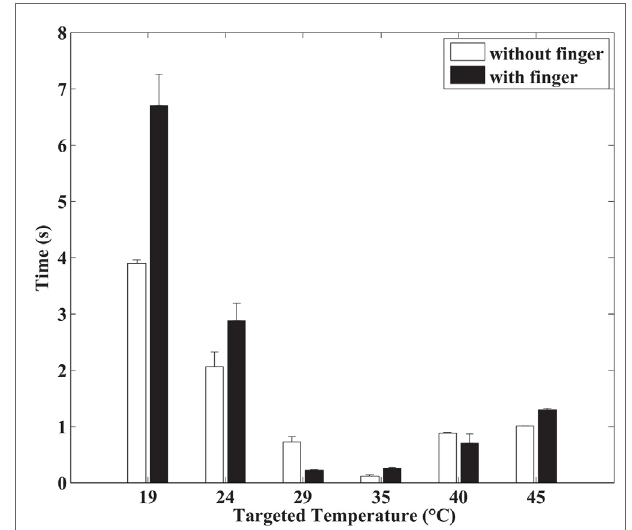
FigUre 3 | effect of thermal load and temperature step magnitude on the temperature change rate . Rise and fall time (from 10 to 90% of the desired value and 90 to 10%, respectively) were measured (six different steps, all starting from 32°C) with and without finger contact. Smaller time indicates faster response of the device (higher bandwidth). Error bars represent the SD of the